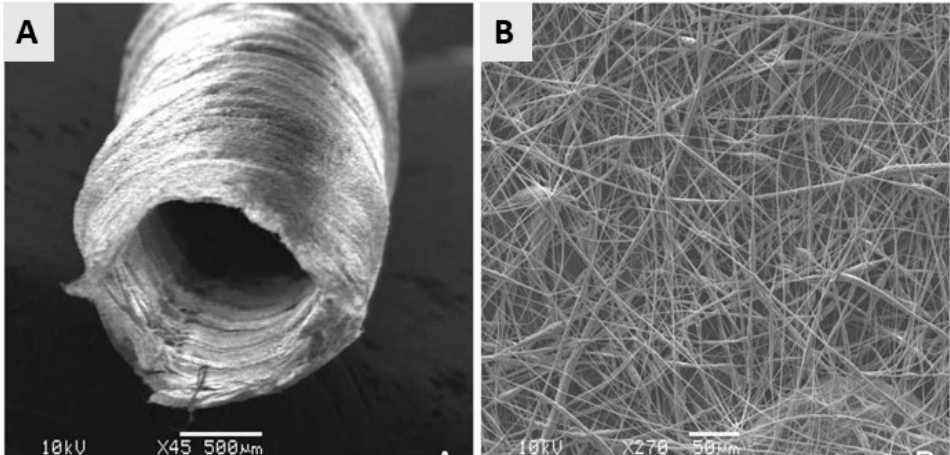
Figure 10. SEM images of the electrospun poly(lactic-co-glycolic acid) (PLGA)/PCL nerve guide conduit and ( A ) magnified details of the tube wall ( B ): microfibers and nanofibers range in diameter from approximately 280 nm to 8 µm—reproduced with permission from [138]. Copyright BMC biotechnology, 2008.